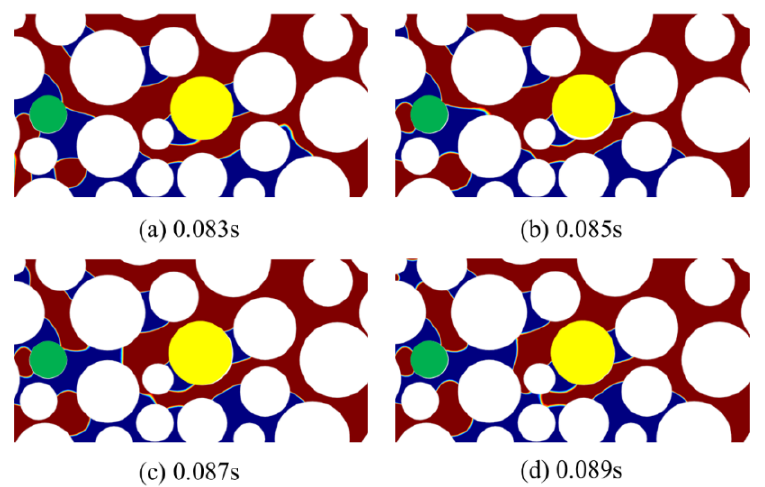
Figure 12. Under strong oil-wetted conditions, snapshots of fluid distributions in an enlarged section of the medium at four instants (contact angle = 60°, log Ca = − 4.25, log M = − 3.00). Red and blue regions represent CO 2 and oil, respectively.